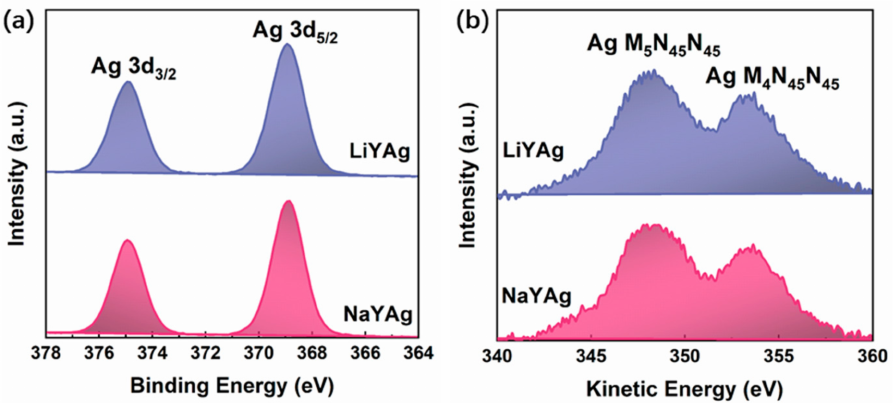
Figure 3. High-resolution XPS spectra of Ag 3d ( a ) and background-corrected Auger spectra of Ag MNN ( b ) in LiYAg and NaYAg, respectively.